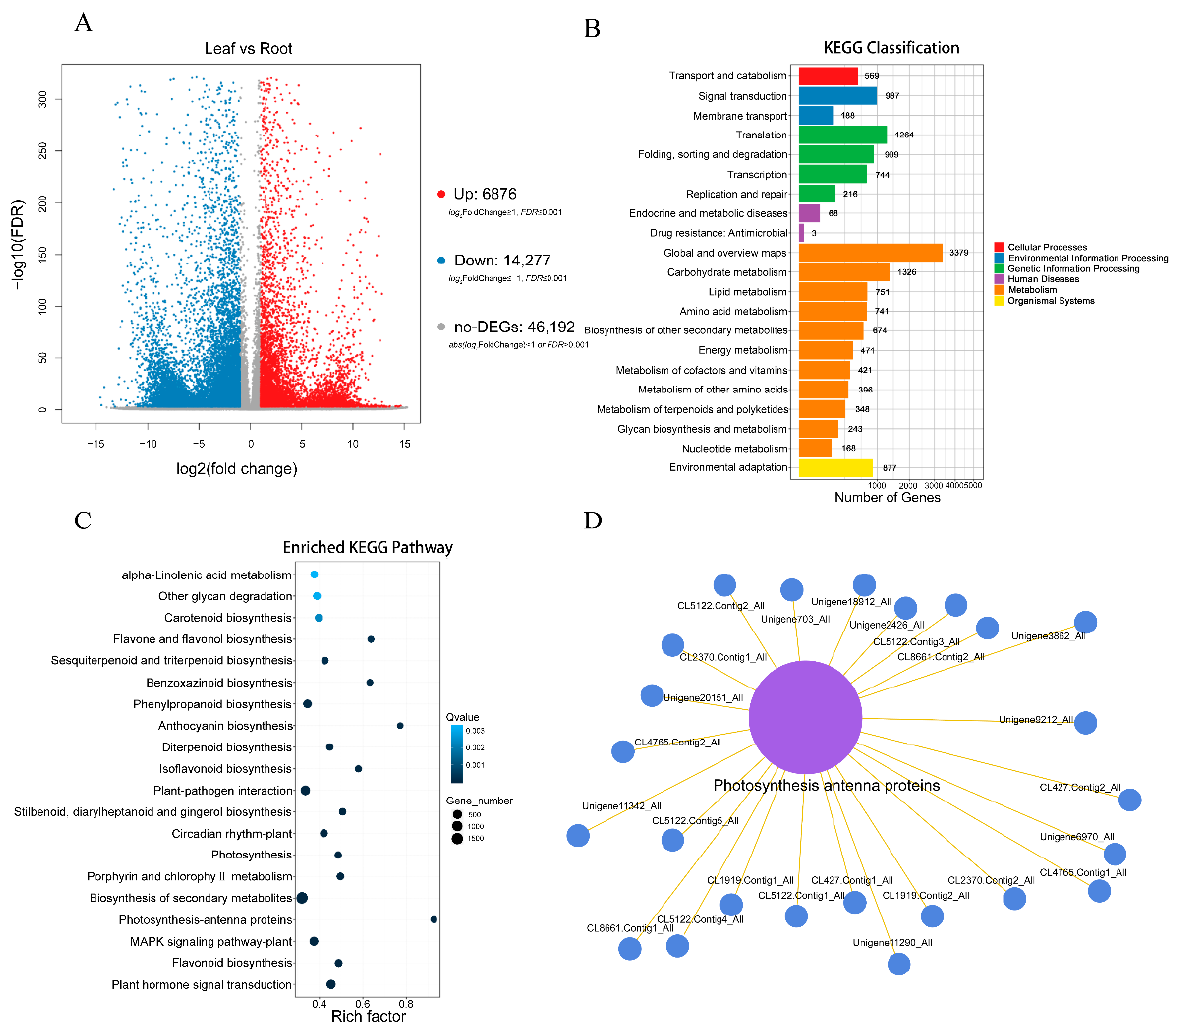
Figure 4. Results of DEGs in different parts of T. hemsleyanum . ( A ) Volcano plots for DEGs from leaves vs. roots; ( B ) KEGG classification of DEGs from leaves vs. roots; ( C ) Scatter plot of differentially expressed T. hemsleyanum genes in the 20 most enriched KEGG pathways (the y-axis shows KEGG pathways, and the x-axis shows rich factor; the size of a point represents the number of DEGs, and the color of a point represents its q-value); ( D ) Network of differentially expressed T. hemsleyanum genes enriched in the photosynthesis-antenna proteins.